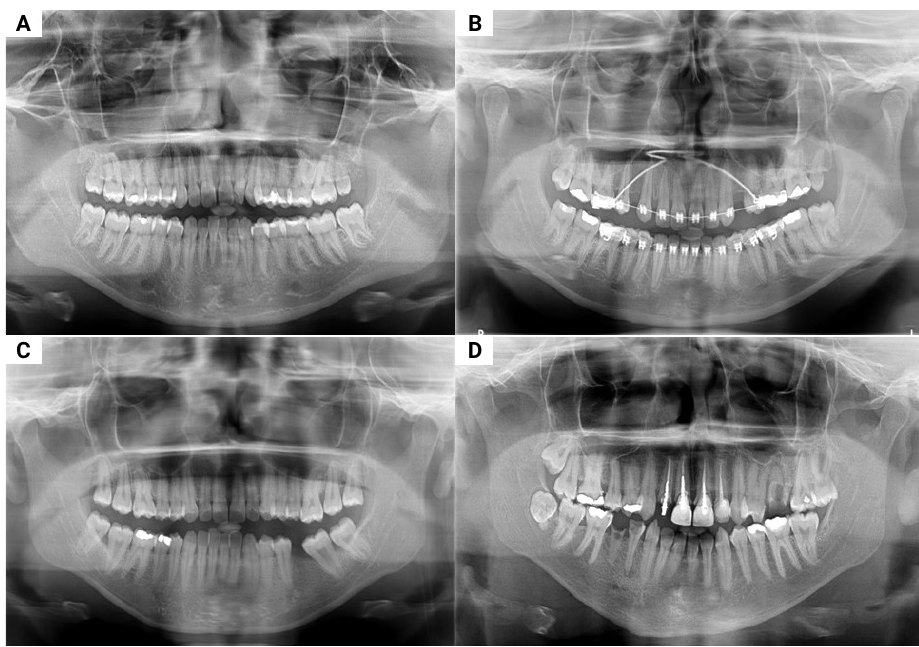
Figure 1. Radiographic findings of dental changes. A) Microdontia in the upper second molars. B) Upper third molar microdontia and orthodontic treatment. C) Presence of taurodontia on the lower second molars. D) Residual roots in the left upper second premolar and right lower second premolar, gyroscopic rotation in the left upper first molar, impacted right lower third molar and orthodontic treatment in the upper